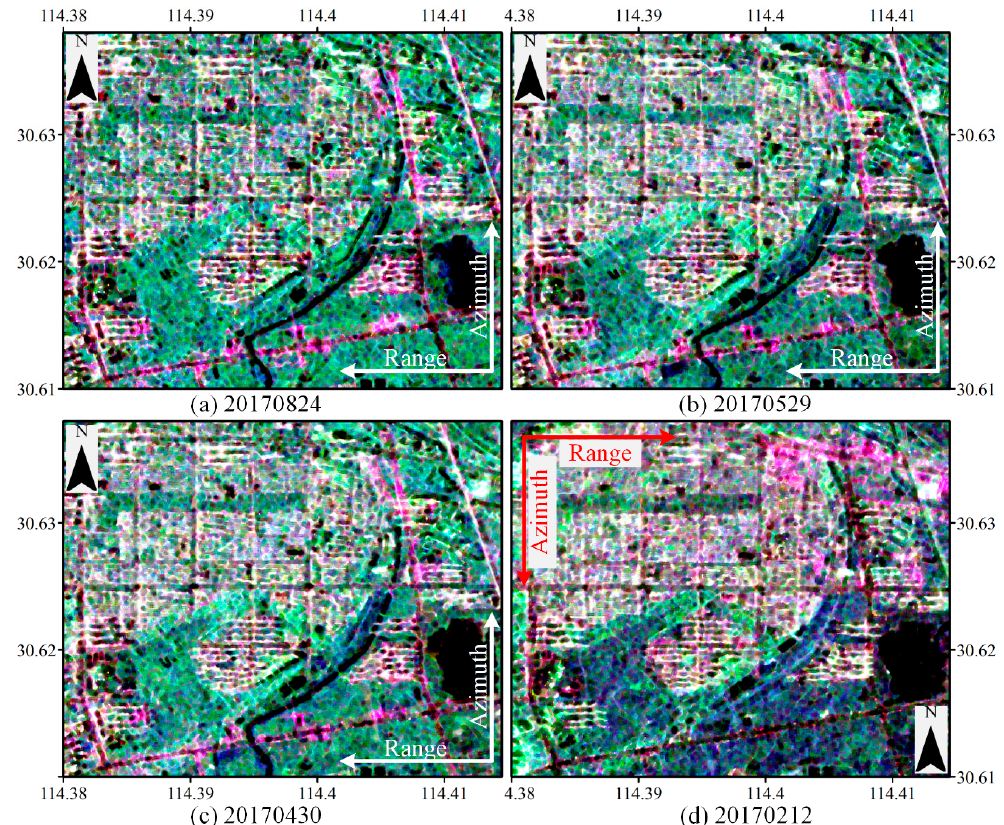
Figure 4. Pauli RGB images of the first group of time-series images, with red |𝑆 (cid:3009)(cid:3009) − 𝑆 (cid:3023)(cid:3023) | (cid:2870) , green 4|𝑆 (cid:3009)(cid:3023) | (cid:2870) , and blue |𝑆 (cid:3009)(cid:3009) + 𝑆 (cid:3023)(cid:3023) | (cid:2870) . The image of 20170824 is the source domain and the other images are the target domain. Table 2. Description of the first group of time-series